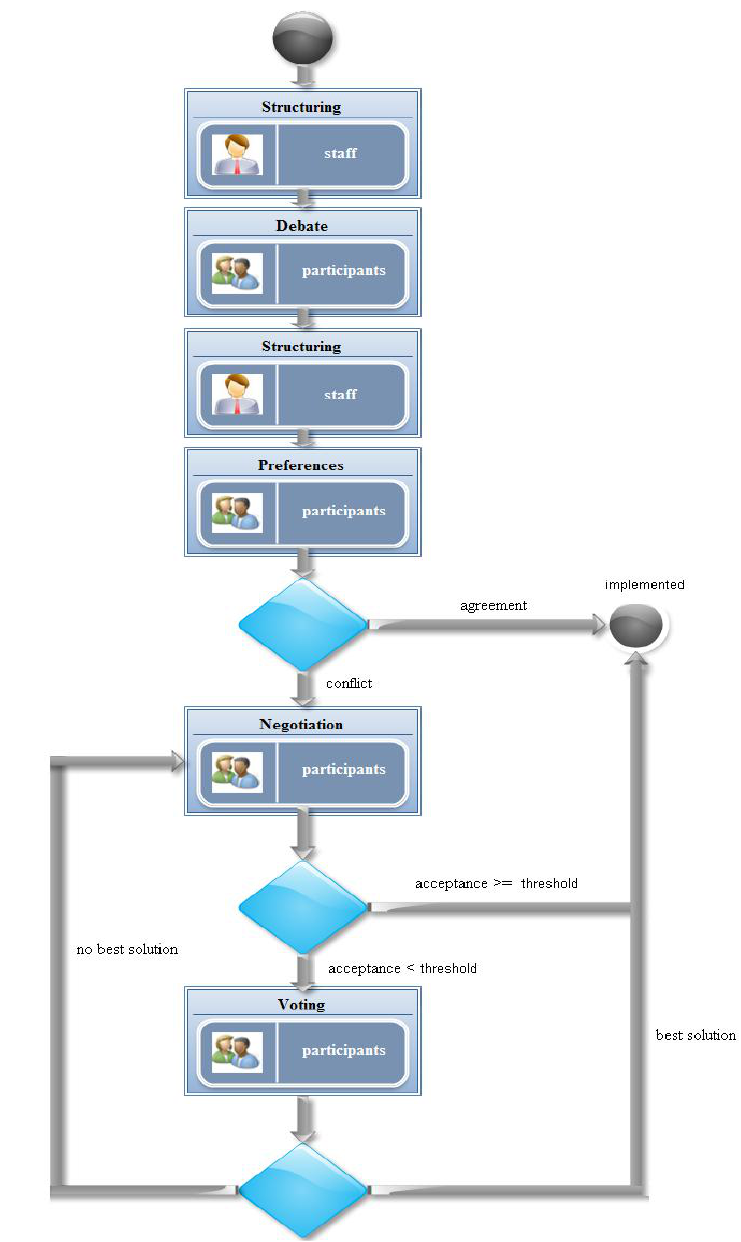
Figure 2: General Scheme of Participatory